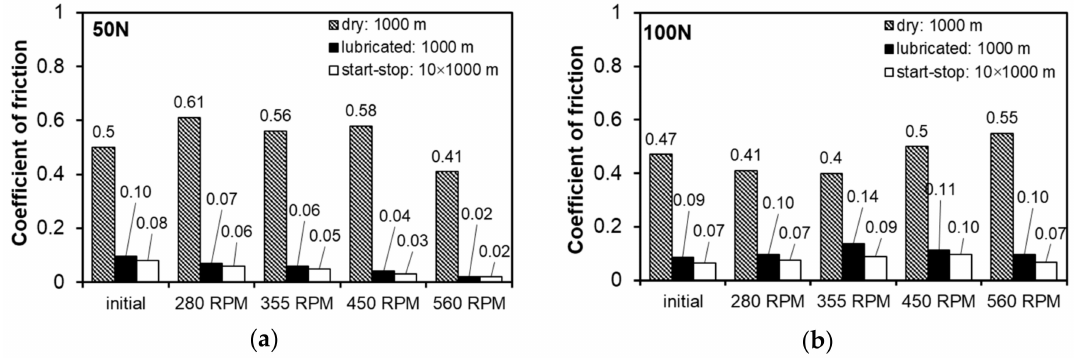
Figure 10. Coe ffi cient of friction: ( a ) determined at load of 50 N, ( b ) determined at load of 100